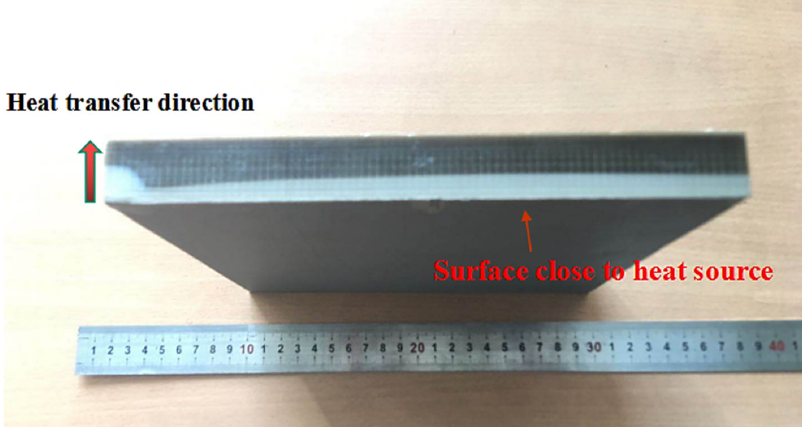
Figure 13. Gradient delamination of the base material PEEK FDM test piece during the heat transfer process.